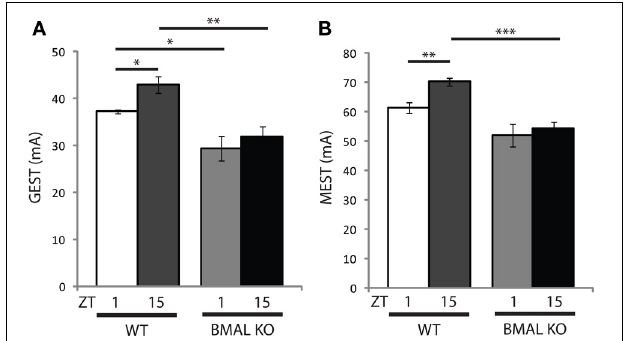
FIGURE 4 | Diurnal effects on seizure endpoints are blocked in BMAL1 KO mice. (A) and (B) Endpoints of electroshock-induced seizures for the BMAL KO mice in the light-period (ZT1) and dark-period (ZT15) fail to show differential percent probability of no response in either (A) generalized (GEST) or (B) maximal (MEST) electroshock seizure threshold. (A) Median trial number to reach GEST: Light = 7, Dark = 7; Logrank test, P = 0 . 9703; N = 6–7 per group. (B) Median trial number to reach MEST: Light = 17, Dark = 18; Logrank test, P = 0 . 8362; N = 6–7 per group.